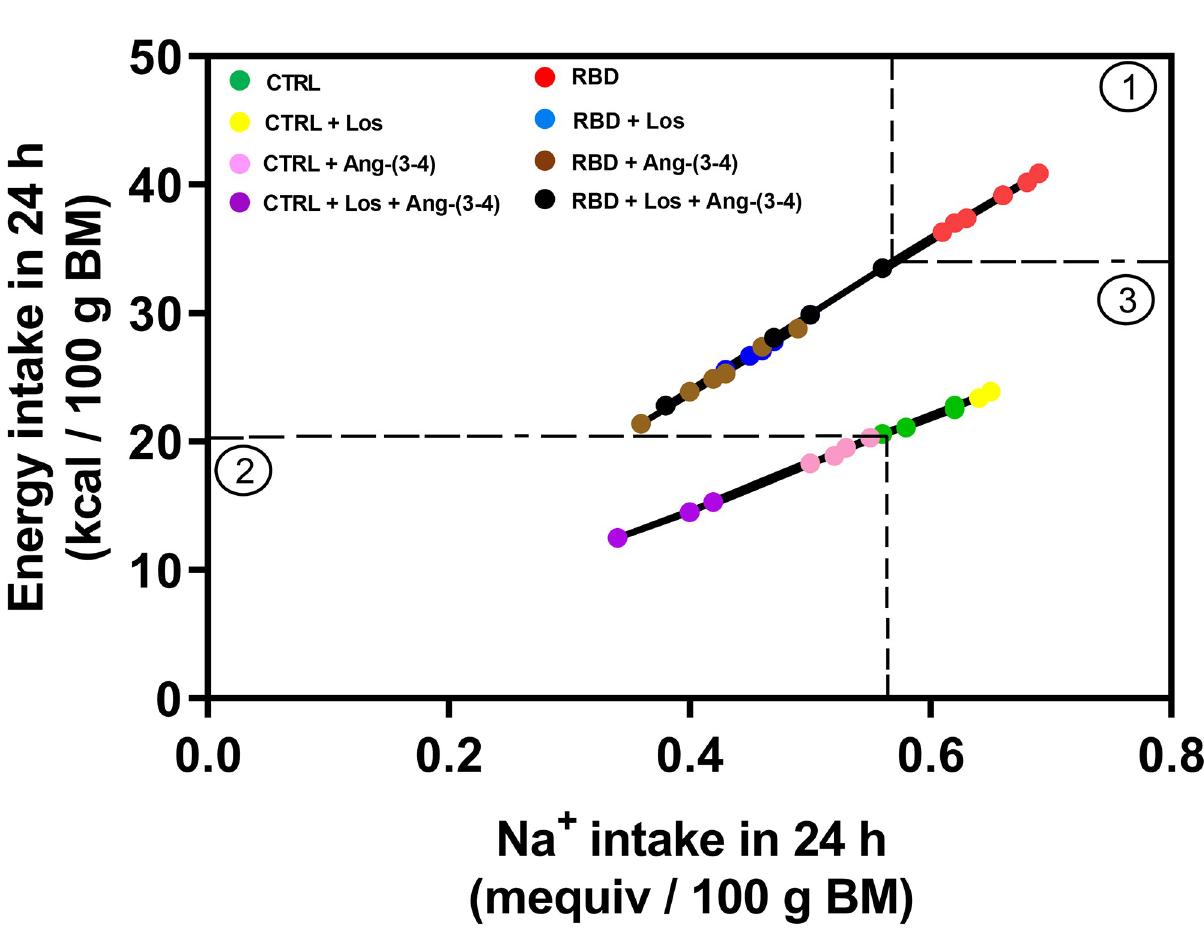
Fig 6. Na + density. Correlation between Na + intake and energy intake. Data points were calculated from the corresponding values given in Figs 5 and 6; n = 5 (CTRL), n = 8 (RBD), n = 5 (CTRL+Los), n = 6 (RBD+Los), n = 5 (CTRL+Ang-(3–4)), n = 8 (RBD+Ang-(3–4)), n = 5 (CTRL+Los+Ang-(3–4)), n = 6 (RBD+Los+Ang-(3–4)). The dashed lines delimit the 3 different clusters of Na + densities (circles) described in the text. Upper line: RBD (red), RBD+Los (blue), RBD+Ang-(3–4) (brown), and RBD+Los+Ang-(3–4) (black). Bottom line: CTRL (green), CTRL+Los (yellow), CTRL+Ang-(3–4) (pink), and CTRL+Los+Ang-(3–4) (lilac). The function Energy intake = slope × Na + intake was adjusted to the points by the least squares method. Upper line: slope = 59.2 kcal/mequiv of Na + ; r = 0.9996. Bottom line: slope = 36.9 kcal/mequiv of Na + ; r =